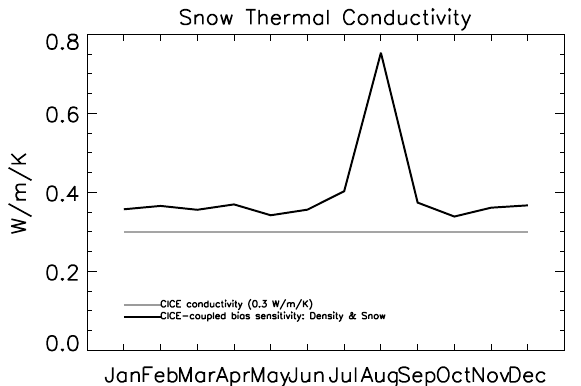
Fig. 6. On-ice snow depth in the Arctic Ocean during equilibrated period of integration (last 20yr of 60yr